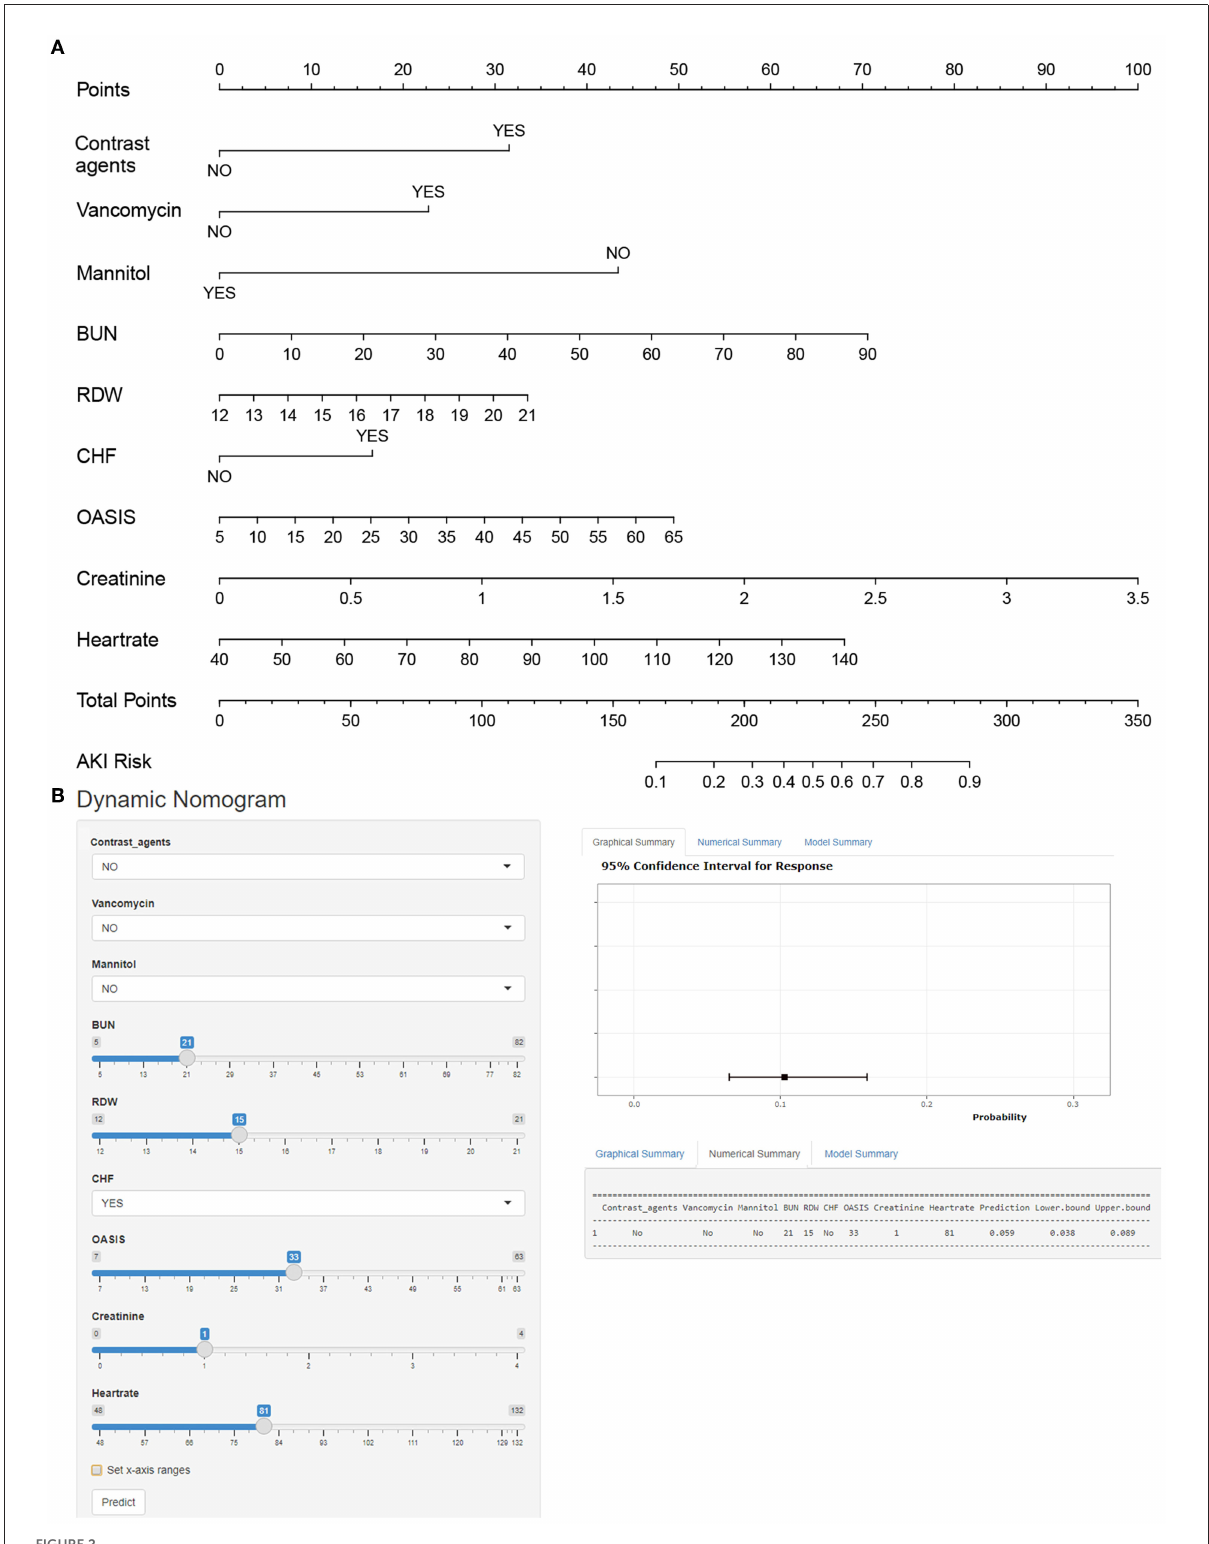
FIGURE2 (A) Nomogram to identify the risk of acute kidney injury (AKI) in patients with AIS, based on logistic regression analysis. To acquire the corresponding scores for each variable, draw a vertical line upward to the “Points” axis. Sum the score for all predictors and locate the final value on the “Total Points” axis. Draw a line straight down to the “Risk” axis to determine the risk of AKI. (B) Dynamic nomogram line graph interface. BUN, blood urea nitrogen; RDW, red blood cell width; CHF, congestive heart failure; OASIS, Oxford Acute Severity of Illness